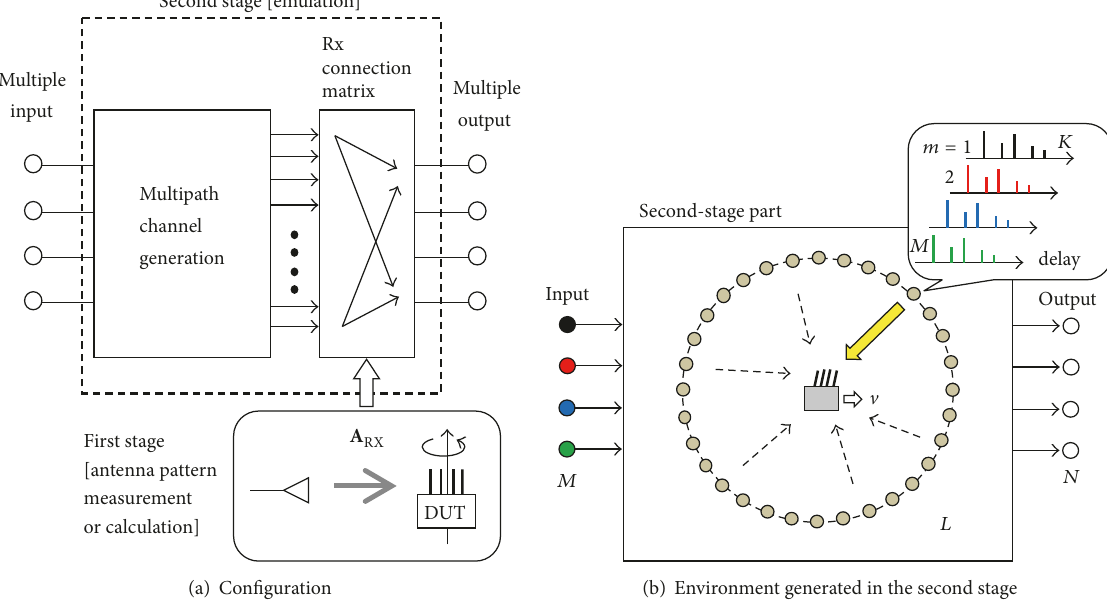
Figure 4: Two-stage fading emulation